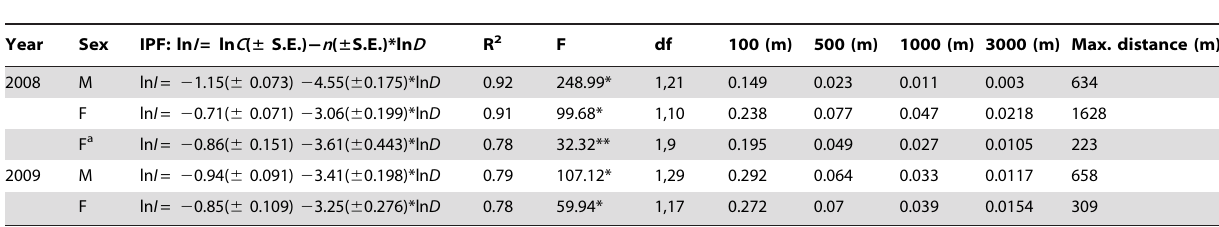
Table 3. Results of fitting the inverse power function (IPF) to movements of the Rosalia longicorn and predicted probability of movements to 100 m, 500 m, 1000 m and 3000